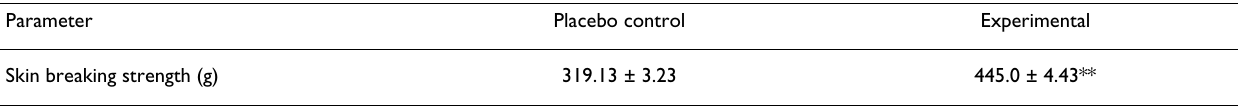
Table 1: Wound healing effect of C. roseus in Incision wound model